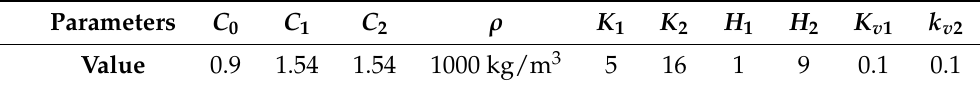
Table 2. The specific values of the hydrodynamic and controller parameters.